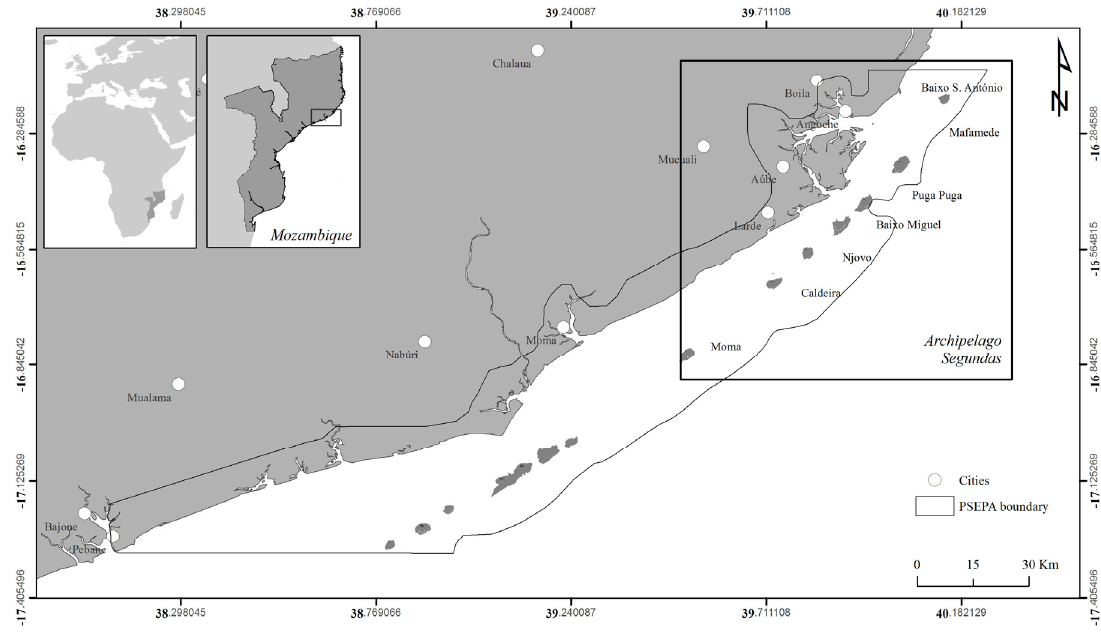
Figure 1. Locational map of the study area.